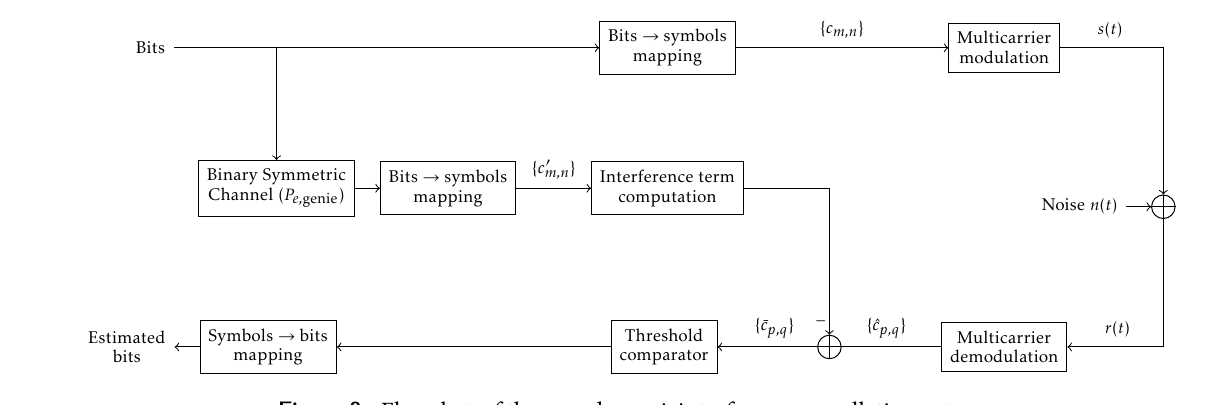
Figure 8. Flowchart of the pseudo-genieinterferencecancellationsystem.